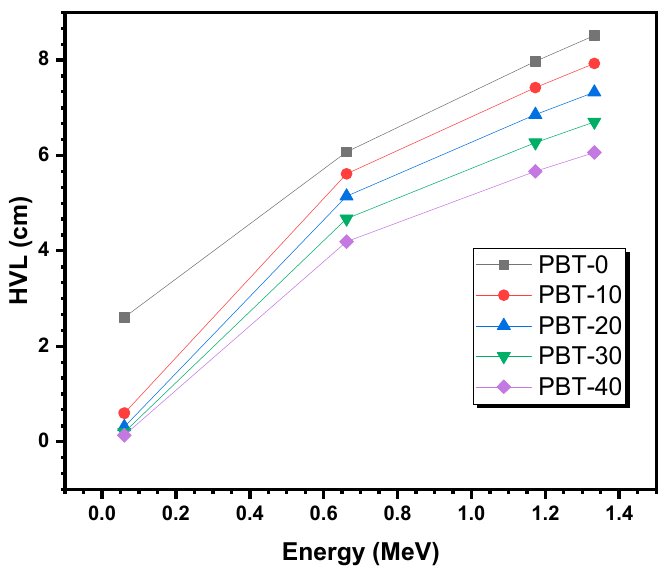
Figure 5. The half value layer (HVL) of the polymer samples.